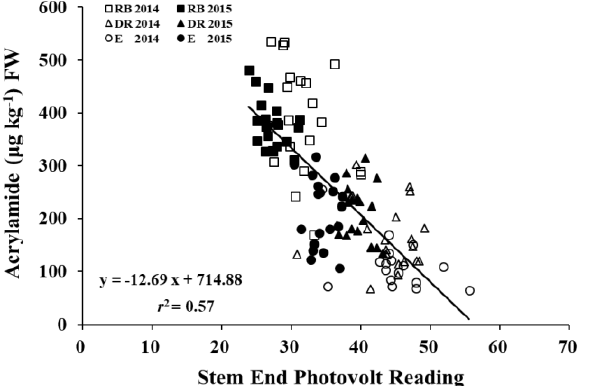
Figure 11. Relationship between stem-end fry color and acrylamide concentration of French fries from tubers stored for 16 weeks at 7.8 °C in 2014 and 2015.